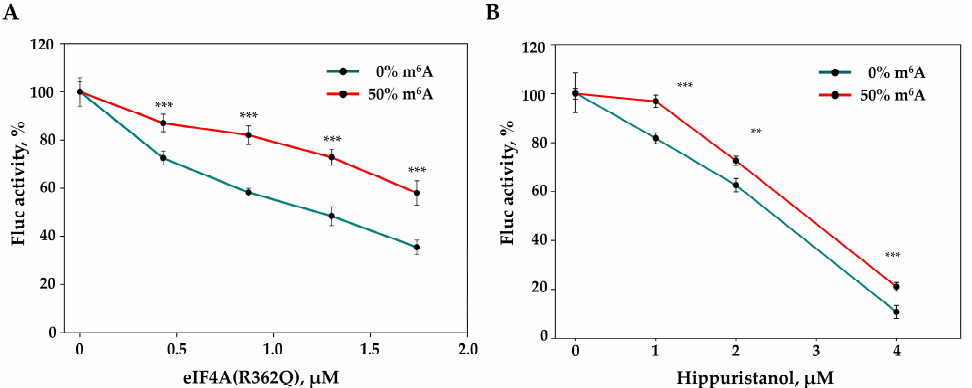
Figure 5. Comparison of translation of unmodified and m 6 A-modified reporter mRNA in the presence of eIF4A (R362Q) ( A ) or hippuristanol ( B ). C + A + Firefly luciferase reporter mRNA carrying the beta-globin 5 (cid:48) UTR (0.15 pmol) was translated in HEK293T cell extract with or without increasing concentrations of recombinant eIF4A (R362Q) (0.43, 0.87, 1.3, and 1.74 µ mol) or increasing concentrations of hippuristanol (1, 2, and 4 µ mol). The reaction mixture was incubated for 60 min at 30 ◦ C before the determination of Firefly luciferase activity, which was taken to be 100% with no eIF4A (R362Q) or hippuristanol added. The results of three independent experiments are presented. Bars are 2 standard deviations. A two-tailed Student’s t-test was used to estimate the statistical significance; ** p < 0.01; *** p < 0.001.